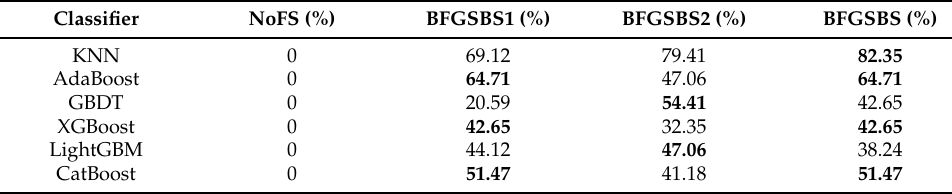
Table 9. The influence of the XGBoost feature importance metrics on